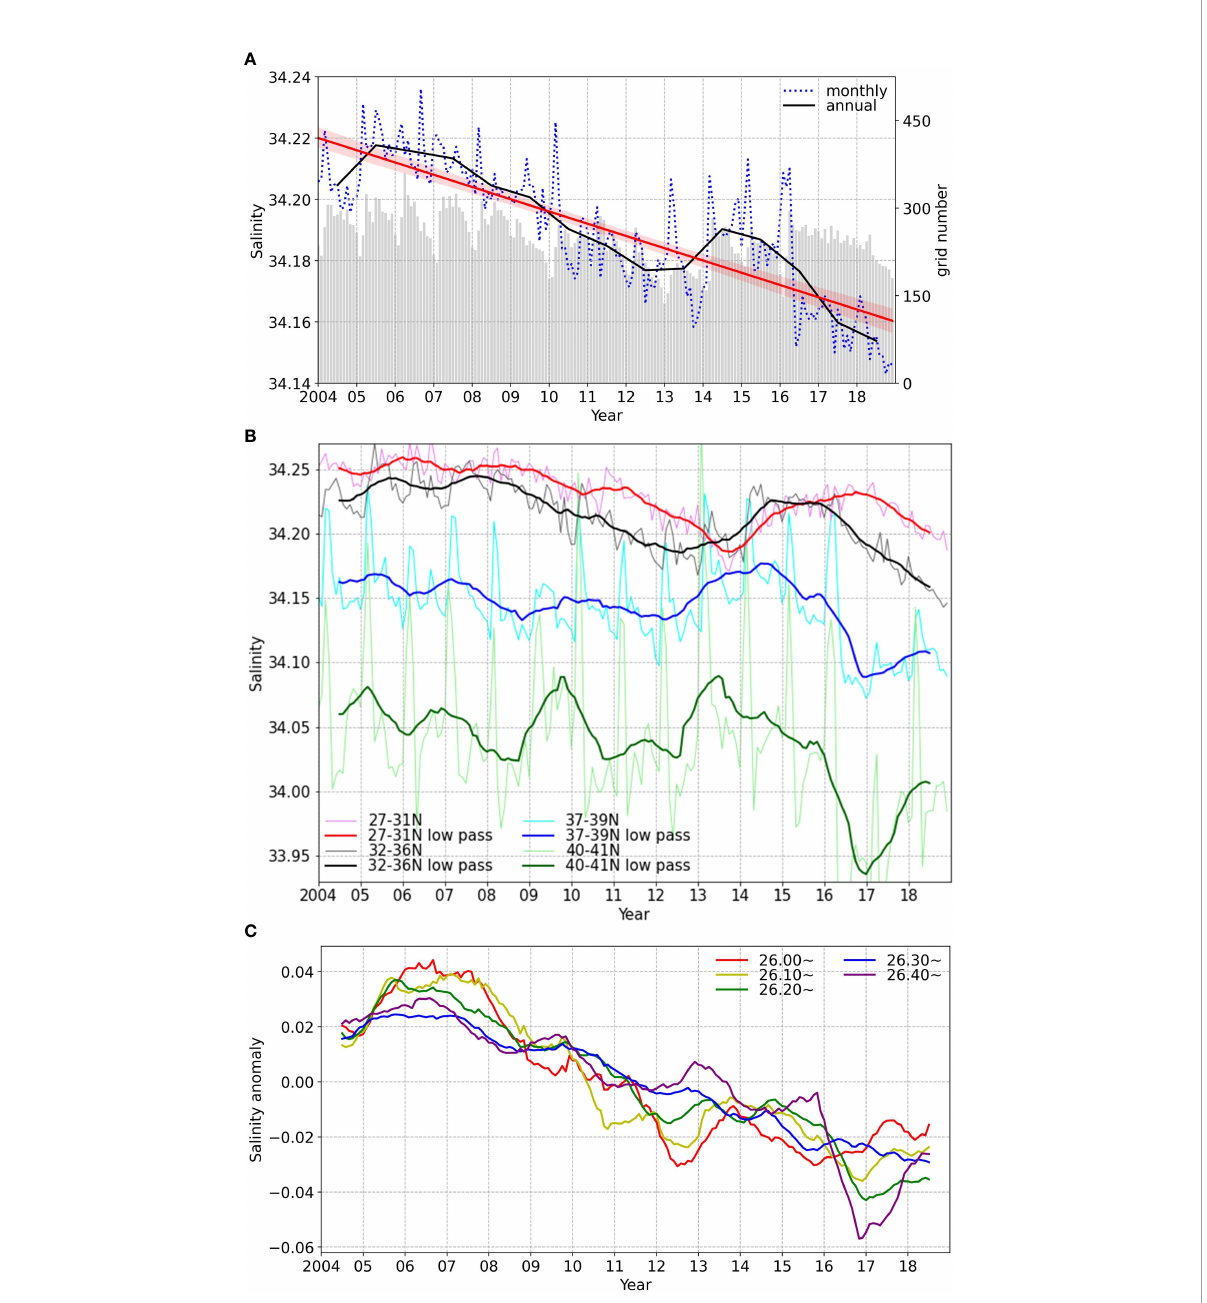
FIGURE 6 Same as in Figure 5 but for CMW, except that (C) presents salinity anomalies because the salinity ranged between different surfaces and varied signi fi cantly in the CMW. (B) In 27 – 31°N (pink and red), 32 – 36°N (gray and black), 37 – 39°N (light blue and blue), and 37 – 39°N (light green and green). (C) On surfaces at g = 26.00 – 26.05 (red), 26.10 – 26.15 (yellow), 26.20 – 26.25 (green), 26.30 – 25.35 (blue), and 26.40 – 26.45